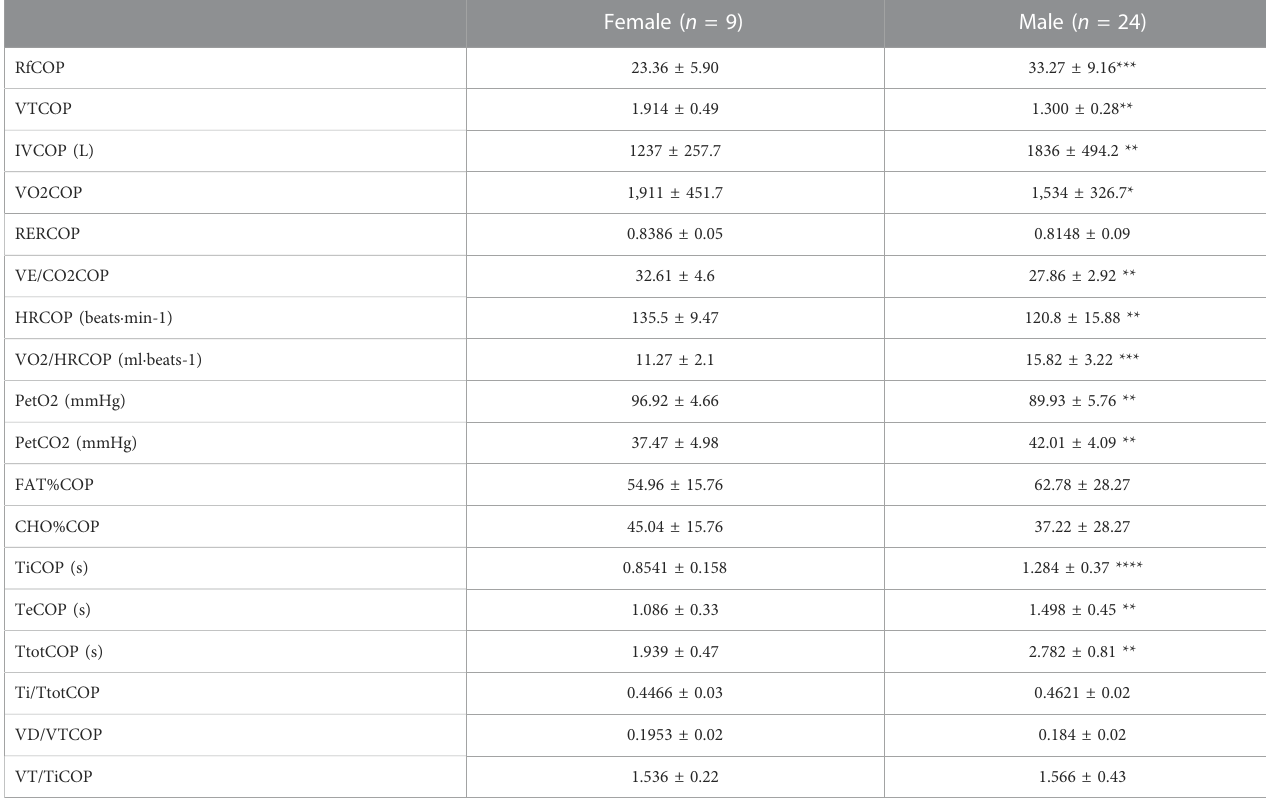
TABLE 2 Cardiopulmonary exercise test variables at